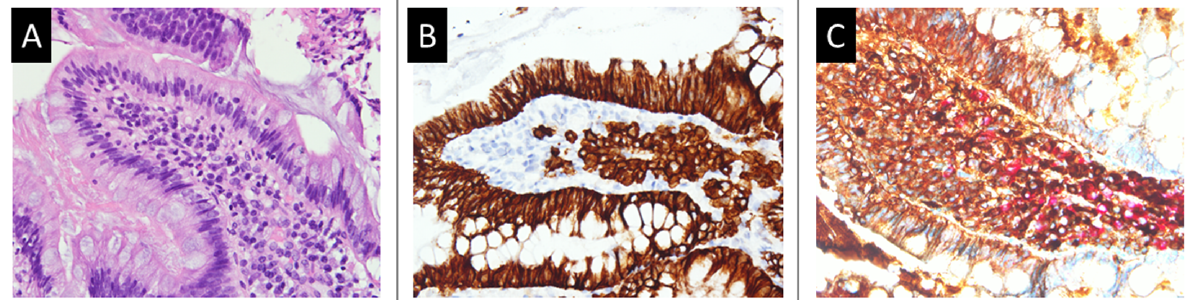
Figure 2. Endoscopy of the duodenum. ( A ) Endoscopy showing a polypoid lesion with a central A1 ulcer in the duodenum with active oozing. ( B ) Treatment with endoscopic electrocoagulation of the